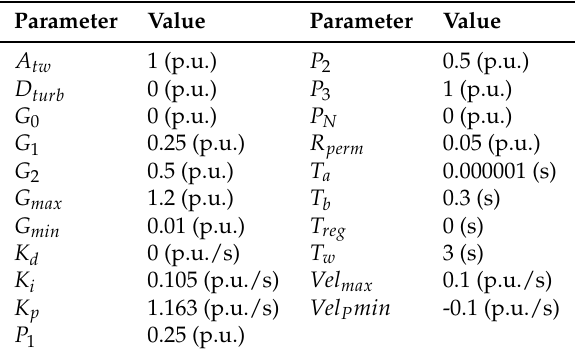
Table A4. Parameters of the governor used in RTDS.